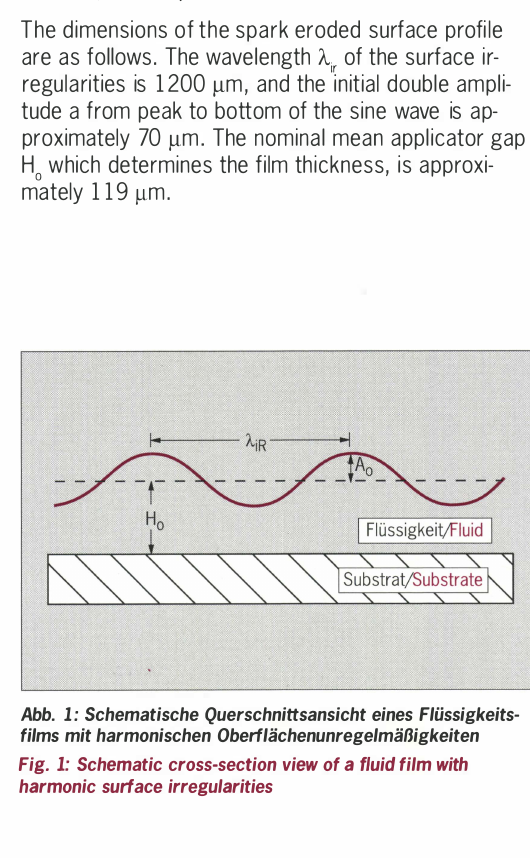
Fig. l: Schematic cross-section view of a fluid film with harmonic surface